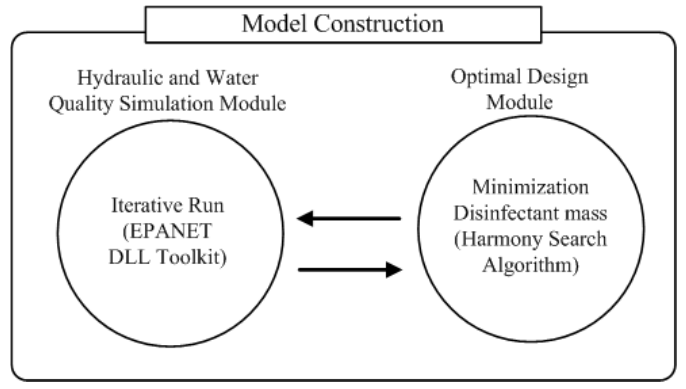
Figure 4. Components of proposed model.